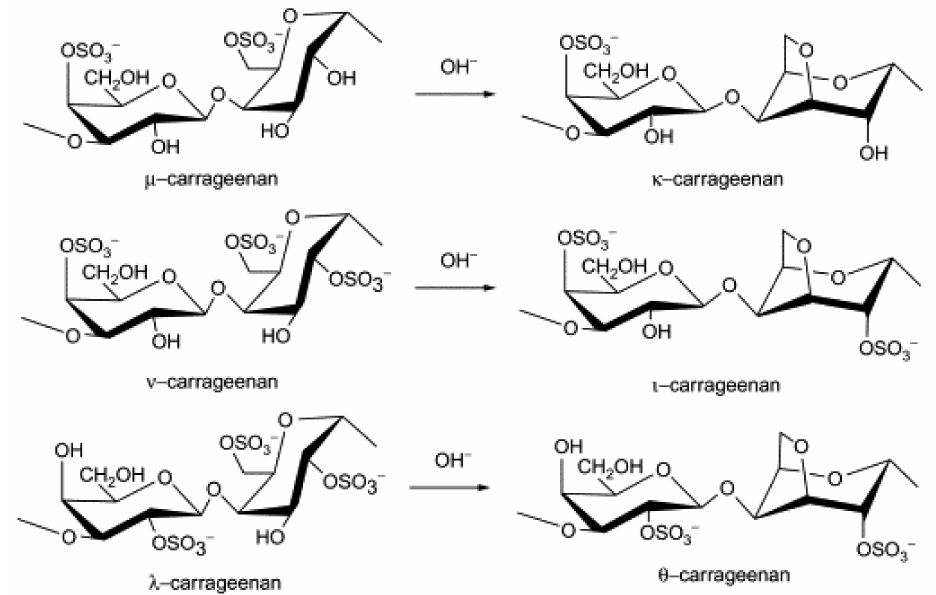
Figure 8. Structures of carrageenans. Reprinted from [61]. Copyright (2014), with permission from